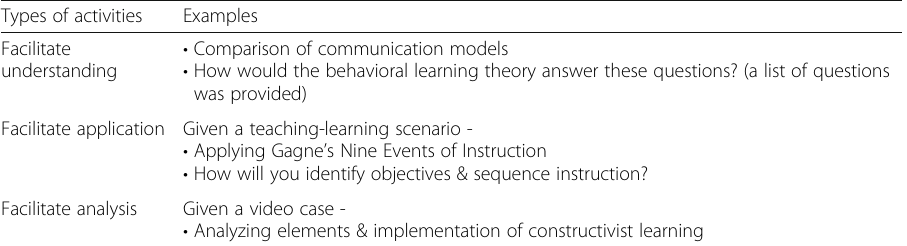
Table 2 Types of Wiki Learning